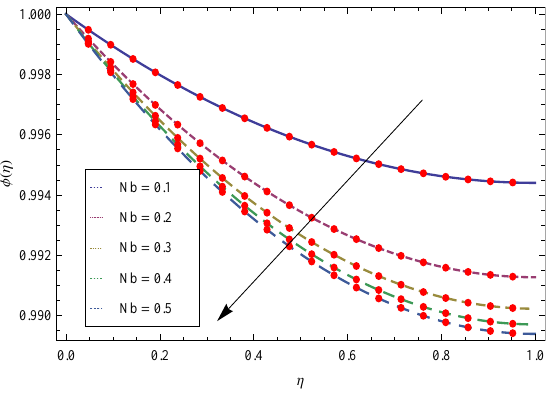
Figure 19. Illustrates the effect of Nb on θ ( η ) , when h = − 0.5, λ = 0.7, S = 0.7,kr = 0.7,Pr = 30, Ec = 0.7, Nt = 0.5, β = 1 and Sc = 0.7.